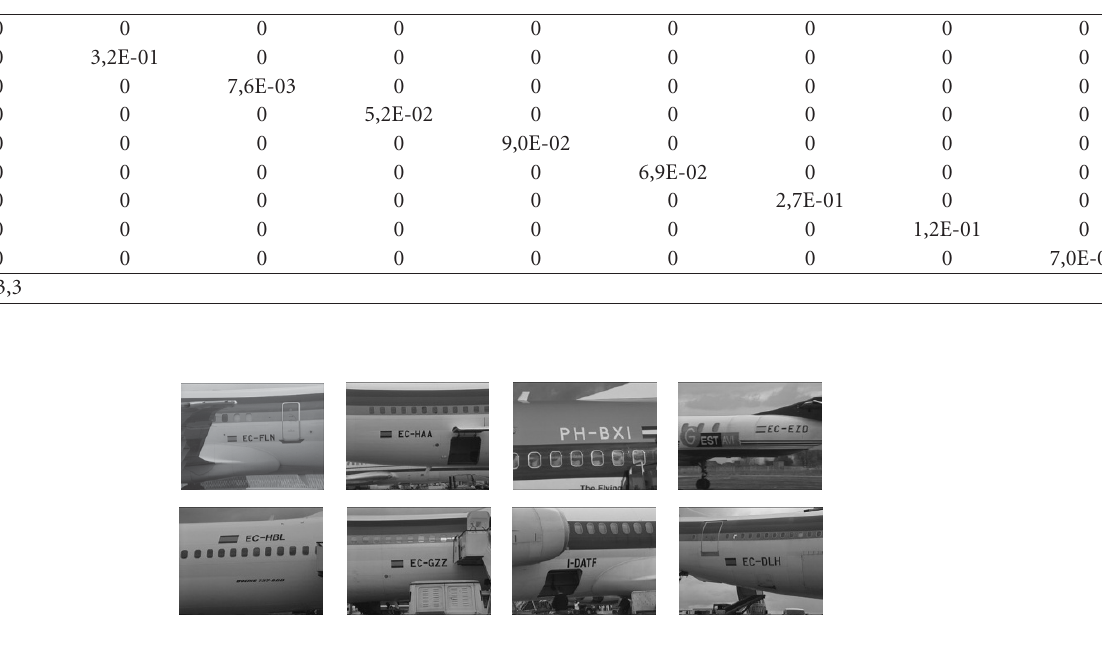
Figure 7: Several test